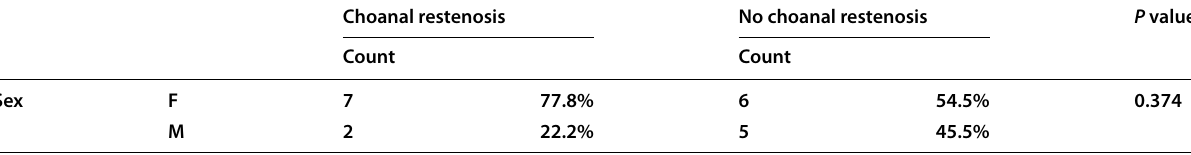
Table 3 Sex distribution in relation to choanal atresia after